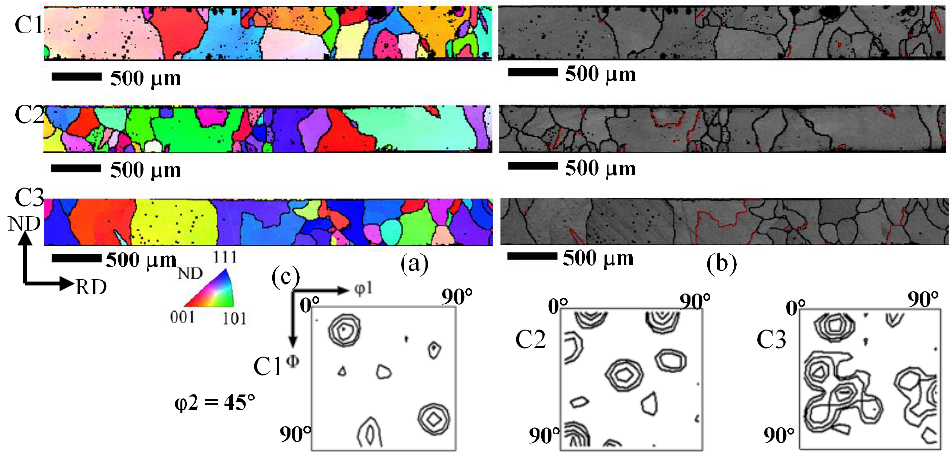
Figure 11. EBSD maps of 1# sheets after final transformation treatment by heating to 1150 °C under three conditions C1 to C3 following cold rolling of hot bands to 0.5 mm. ( a ) IPF-ND maps; ( b ) band contrast maps (red lines: Σ3); ( c ) ODFs at ϕ 2 = 45° section.